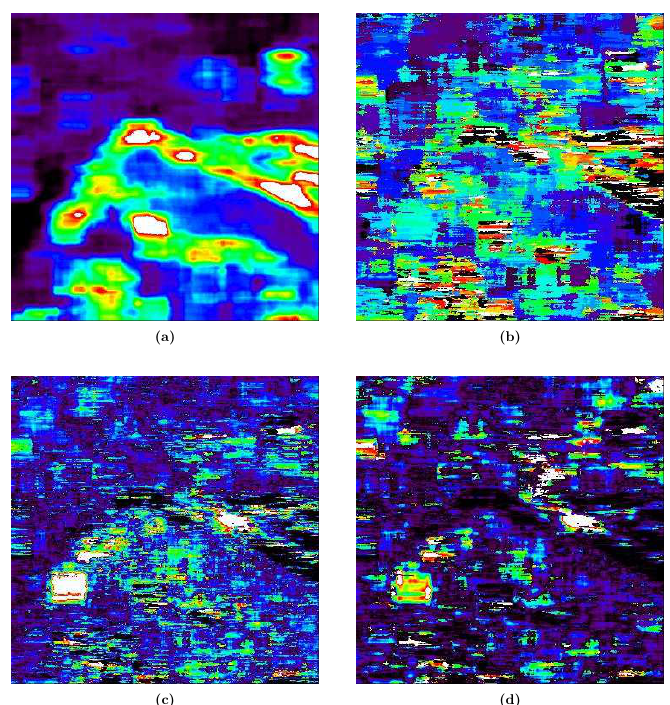
Figure 8. Vario-parameter maps resultant from classification of RADARSAT data set in Figure 3a. Based on first-order directional vario functions in 90 ◦ (north–south) direction calculated for windows of 40 by 40 pixels with offset 1 pixel. ( a ) pond; ( b ) mindist; ( c ) p1; ( d )